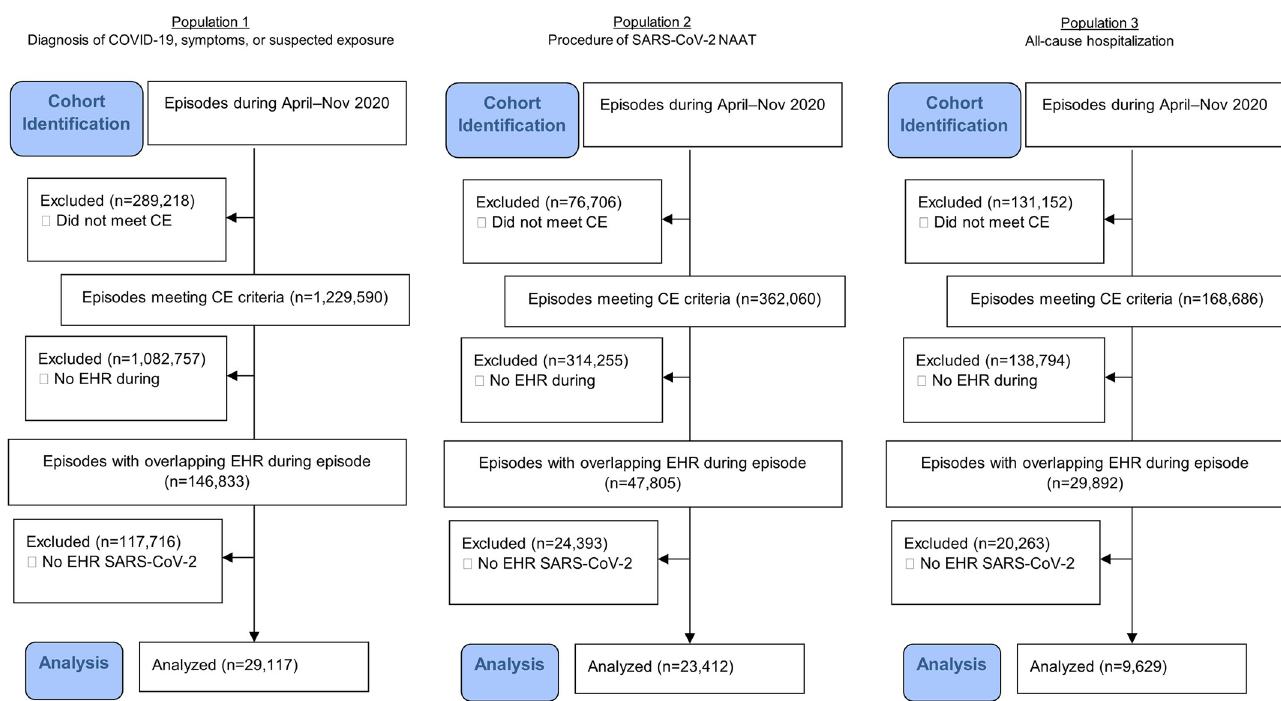
Fig 3. Cohort flow diagram for the Florida Medicaid population in OneFlorida. CE criteria: Individuals must be continuously enrolled with medical benefits during the episode and during the 6-month baseline period prior to the episode. An enrollment gap of up to 31 days was allowed. CE continuous enrollment, EHR electronic health record, NAAT nucleic acid amplification test, SARS-CoV-2 severe acute respiratory syndrome coronavirus 2.